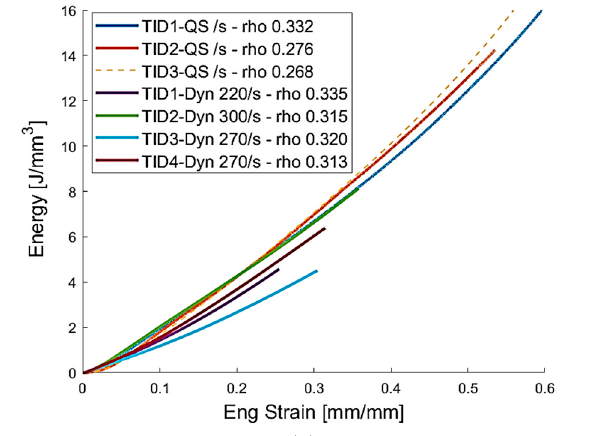
Figure 10. Frames of the video recorded during ( a ) TID3-Dyn and ( b ) TID2-Dyn tests.